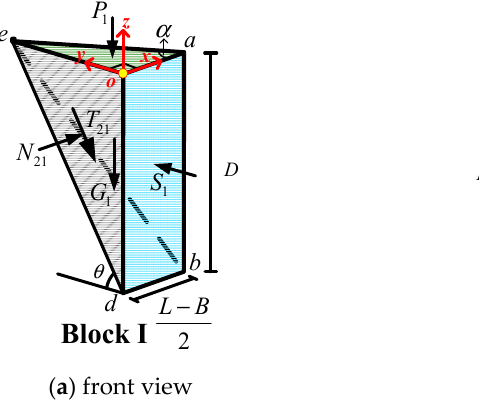
Figure 5. The forces applied on block I. The resultant vertical force of the prism